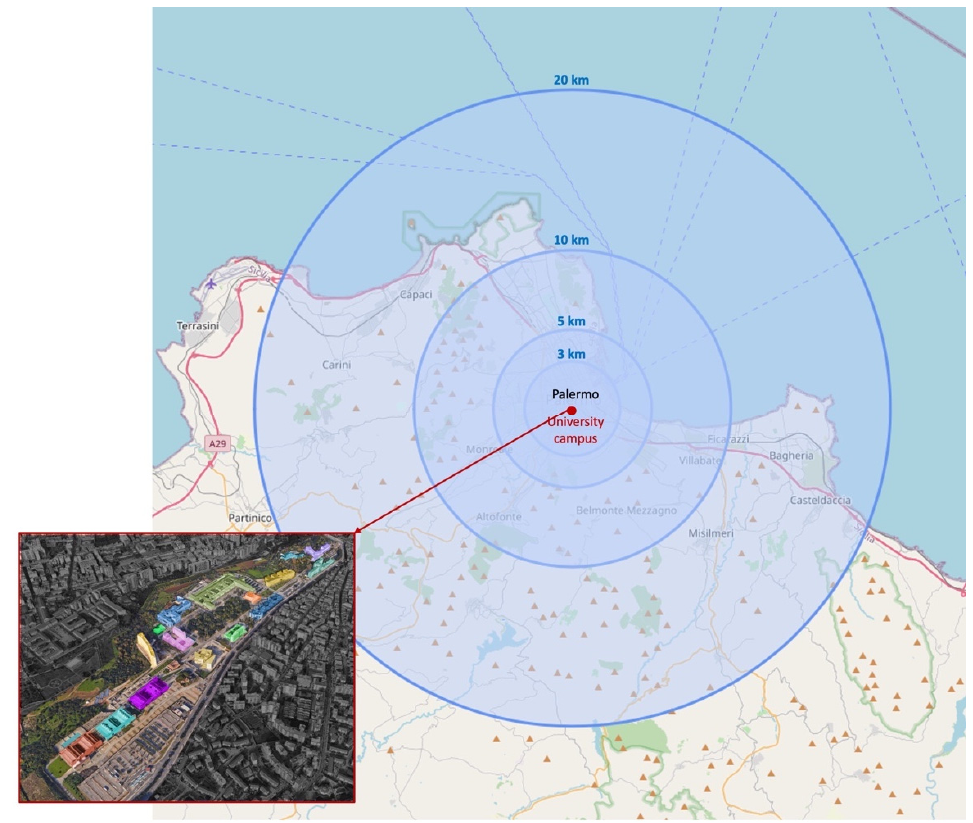
Figure 2. Campus and the circular distances from where commuters originate.